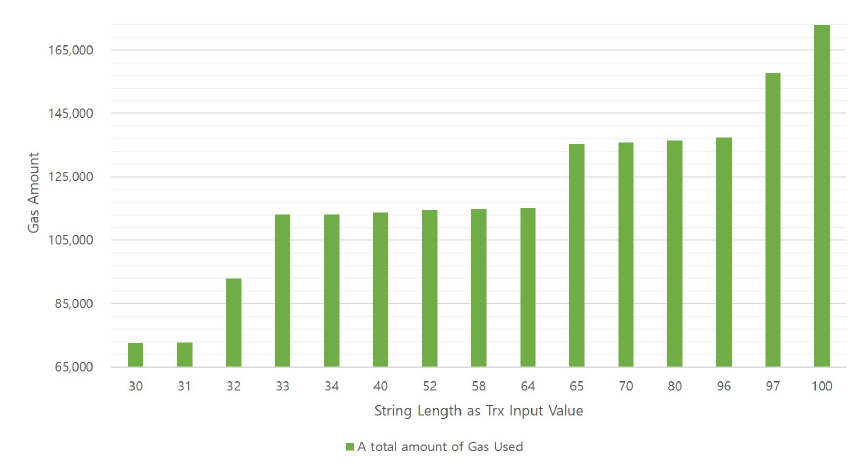
Figure 8. Change of amount of gas consumed with different input lengths of transactions.